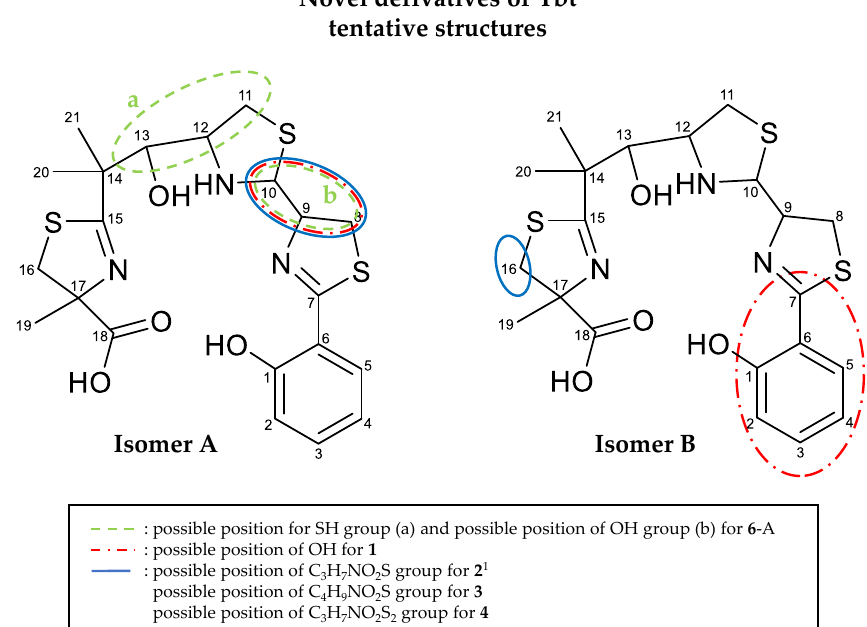
Figure 11. Proposed positions of the modifications of the novel derivatives of Ybt: 1 ([M + H] + : C 21 H 28 N 3 O 5 S 3 + , calculated: m / z 498.1186, measured: m / z 498.1188, ∆ m 0.5 ppm), 2 ([M + H] + : C 24 H 33 N 4 O 6 S 4 + , calculated: m / z 601.1277, measured: m / z 601.1282, ∆ m 0.8 ppm), 3 ([M + H] + : C 25 H 35 N 4 O 6 S 4 + , calculated: m / z 615.1434, measured: m / z 615.1433, ∆ m − 0.2 ppm), 4 ([M + H] + : C 24 H 33 N 4 O 6 S 5 + , calculated: m / z 633.0998, measured: m / z 633.1003, ∆ m − 0.8 ppm), 5 ([M + H] + : C 23 H 31 N 4 O 6 S 4 + , calculated: m / z 587.1121, measured: m / z 587.1127, ∆ m 1.0 ppm), 6 ([M + H] + : C 21 H 28 N 3 O 5 S 4 + , calculated: m / z 530.0906, measured: m / z 530.0911, ∆ m 0.9